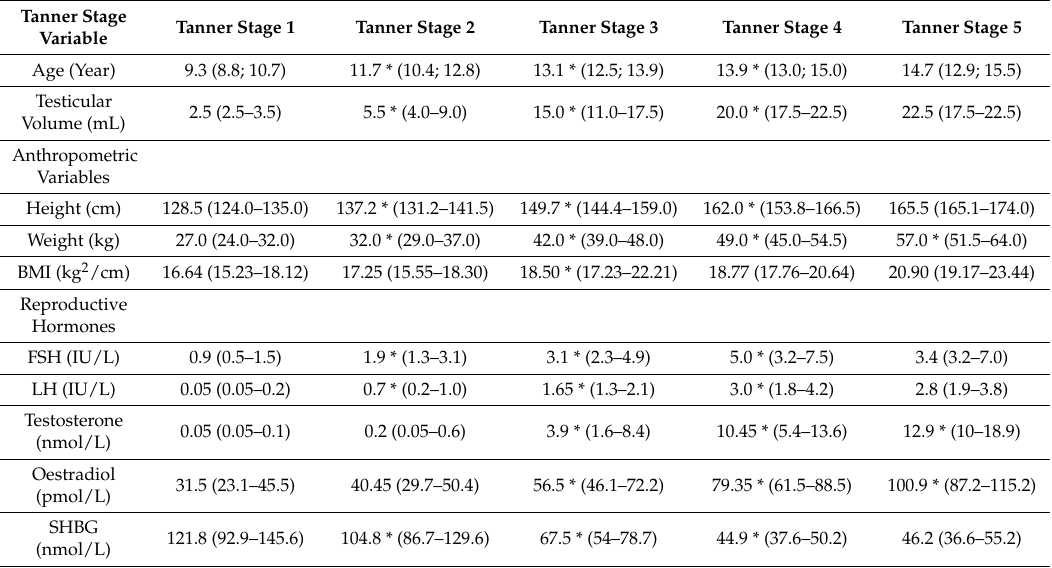
Table 2. Mean and interquartile range of age, testicular volume, anthropometric variables and reproductive hormone levels per tanner stage amongst boys in the rural Western Cape.